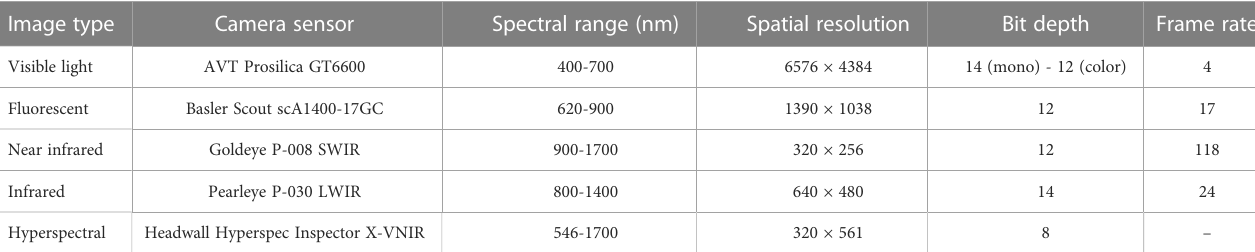
TABLE 1 Camera speci fi cations of the HTPP system at the UNL,